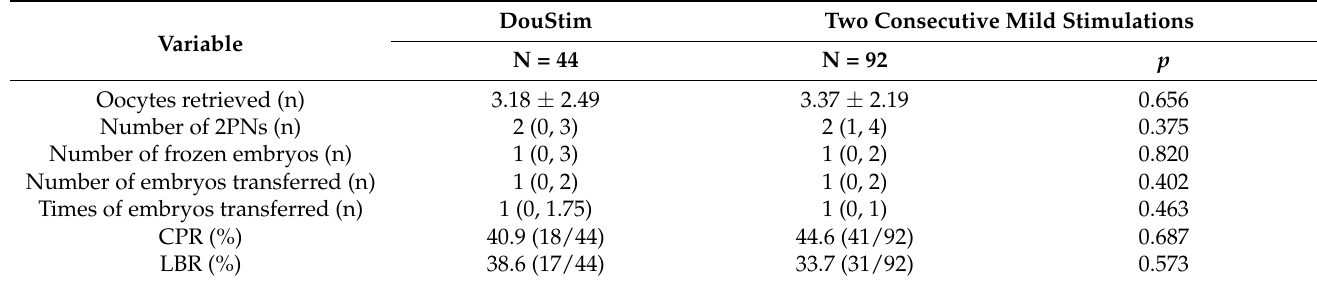
Table 6. Comparison of clinical observation indexes and pregnancy outcomes between the DouStim group and the two consecutive mild stimulations group in young POR patients (ages < 35 years).